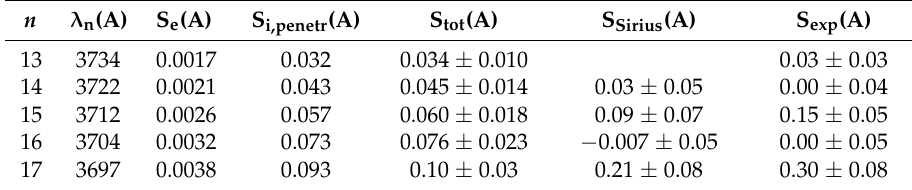
Table 3. Shift S i,penetr due to penetrating ions [39] and its sum S tot with the electronic shift S e for the hydrogen spectral lines H 13 –H 17 , and the comparison with the shifts from paper by Bengtson and Chester [34] observed in astrophysical (S Sirius ) and laboratory (S exp ) plasmas. All of the shifts are in